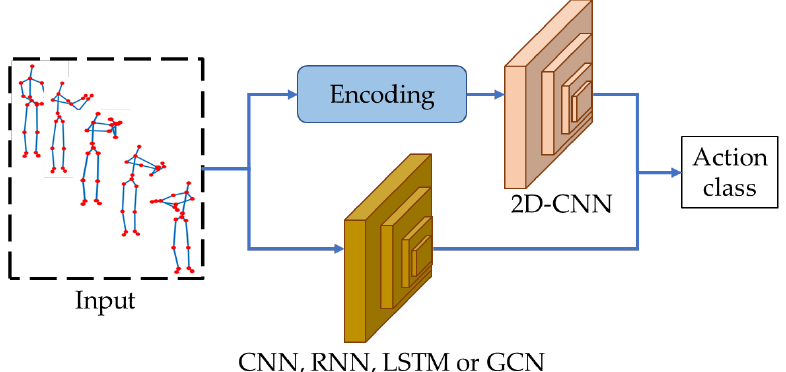
Figure 6. Working scenario of deep learning-based HAR methods.